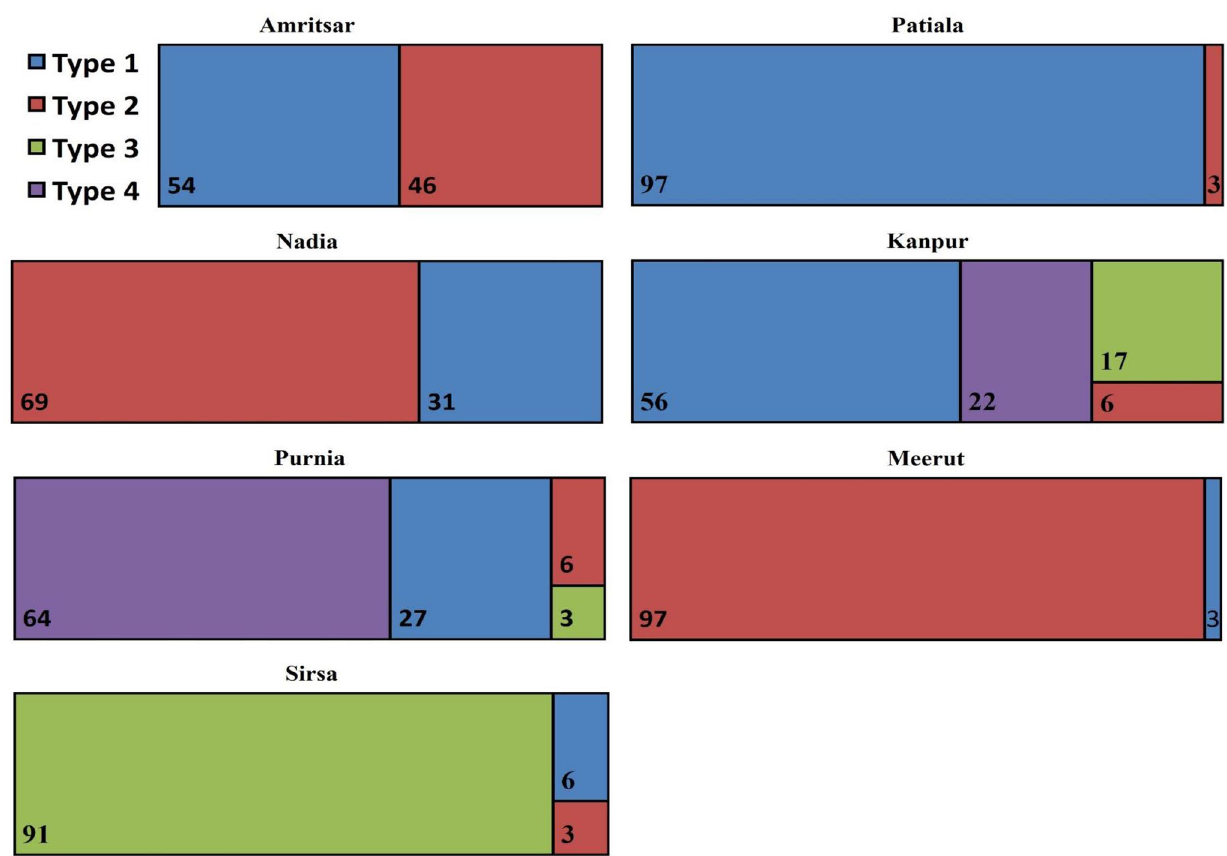
Figure 6. Distribution of farm types (%) in different